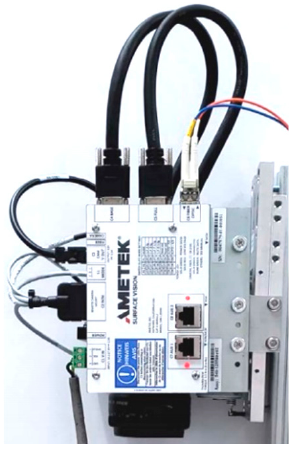
Figure 3. Surface inspection camera.